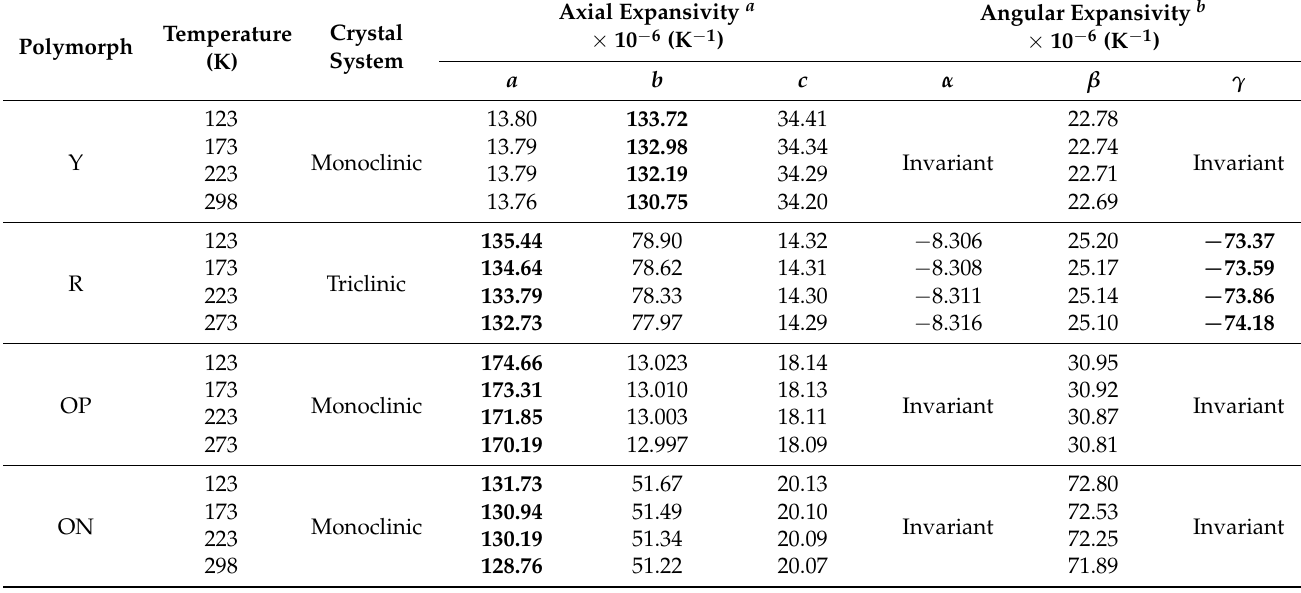
Table 1. Axial and angular expansivities of different ROY polymorphs. The direction of maximum expansivity is highlighted in bold for each polymorph.